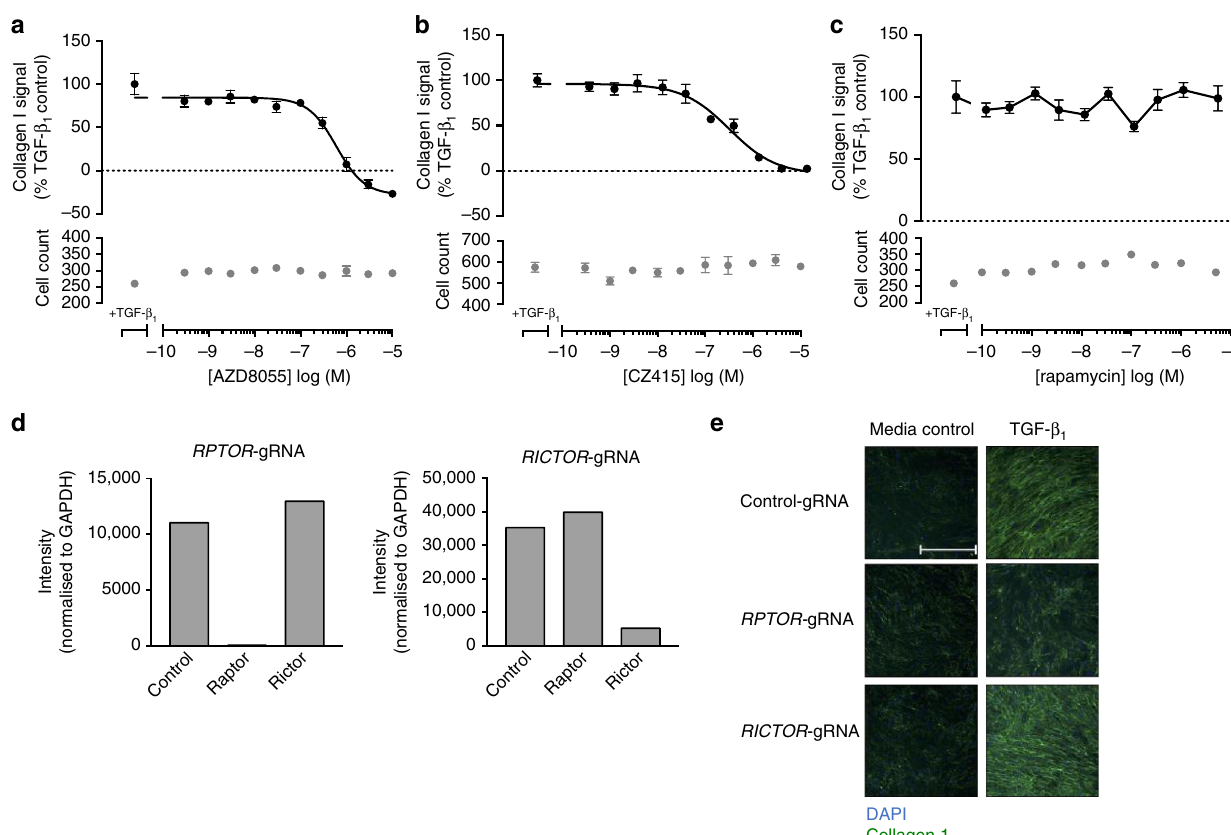
Fig. 7 mTORC1 plays a critical role in mediating the pro- fi brotic effects of TGF- β 1 in IPF-derived lung fi broblasts. IPF human lung fi broblasts (IPF-HLFs) were pre-incubated with vehicle (0.1% DMSO) or increasing concentrations of AZD8055 ( a ), CZ415 ( b ), or rapamycin ( c ) and stimulated with TGF- β 1 (1 ng/ml) for 72 h with collagen I deposition assessed by macromolecular crowding assay. Data are expressed as collagen I signal calculated as a percentage of the TGF- β 1 -treated control ( n = 4 fi elds of view imaged per well) and cell counts obtained by staining nuclei with DAPI. Each data point shown is mean ± SEM ( n = 4) and is representative of 5 independent experiments. IC 50 values were calculated using 4-parameter non-linear regression: AZD8055, IC 50 = 604 nM, 95% CI 415 nM to 1 µ M; CZ415, IC 50 = 245.3 nM, 95% CI 136.7 – 541 nM. Additionally, IPF-HLFs were modi fi ed by CRISPR-Cas9 gene editing using gRNAs targeting exon 26 of RPTOR or exon 29 of RICTOR . Analysis of the resultant levels of Raptor and Rictor protein are shown ( d ). CRISPR-Cas9- edited IPF-HLFs were also stimulated with TGF- β 1 (1 ng/ml) for 72 h, with collagen I deposition assessed by macromolecular crowding assay ( e ).